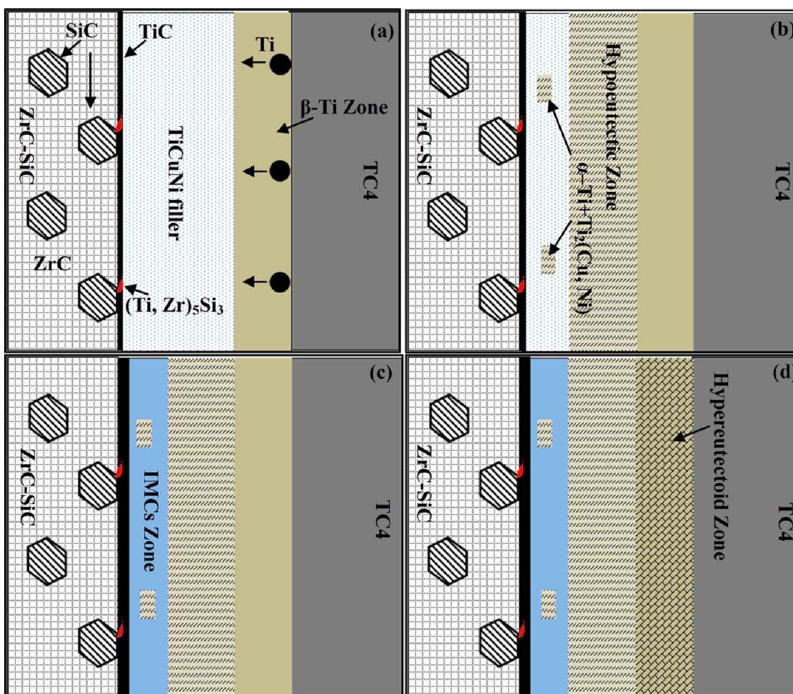
Figure 16. Microstructural evolution model of the Ti6Al4V(TC4)/ZrC-SiC brazed joints: ( a ) Formation of TiC and β -Ti zone, ( b ) formation of the hypoeutectic zone, ( c ) formation of intermetallic compounds (IMCs) zone, ( d ) transformation of the β -Ti zone to hypereutectoid zone, reproduced from Reference [41] with permission of Elsevier, 2018.